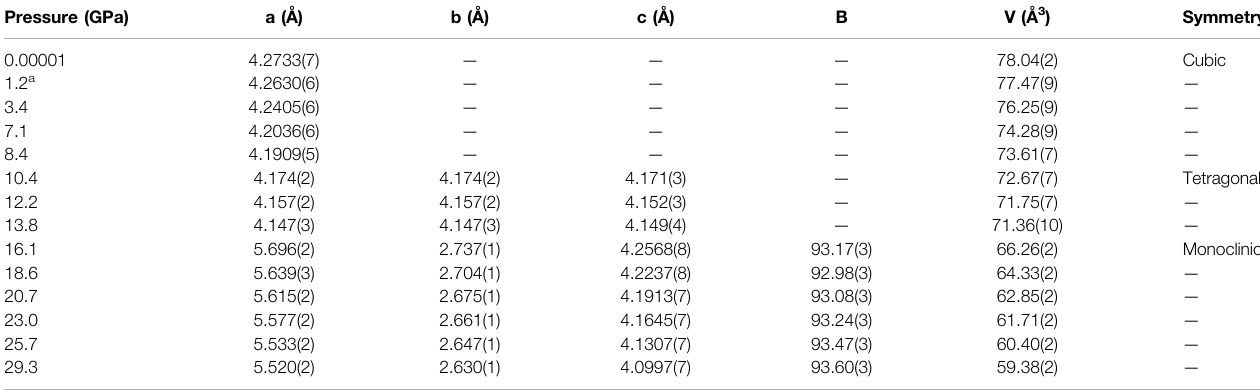
TABLE 2 | Lattice parameters of Cu 2 O (cubic, tetragonal and monoclinic phases) at various pressures. Pressure (GPa)